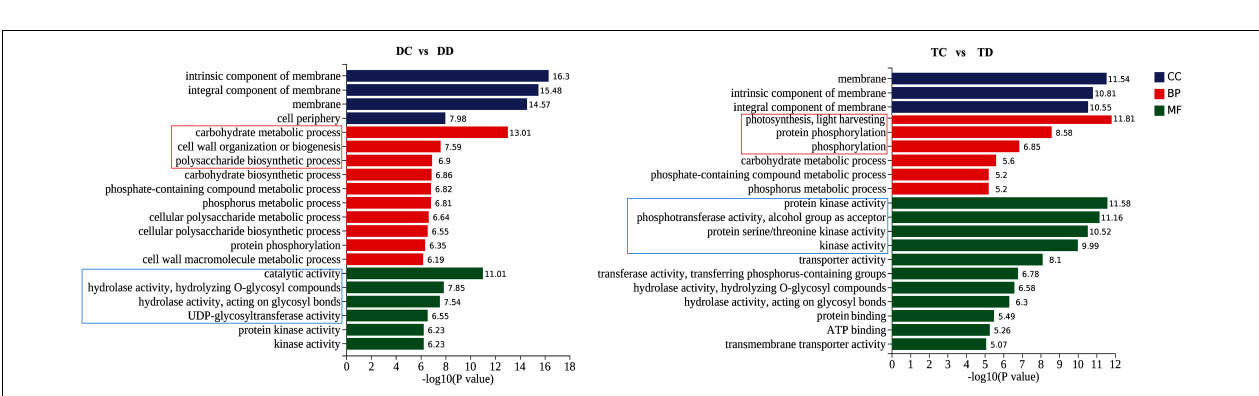
FIGURE 4 | Comparative GO (Gene Ontology) in DC vs DD and TC vs TD enrichment analysis of enriched DEGs. The results are summarized in three main categories: biological process (BP), cellular component (CC), and molecular function (MF).